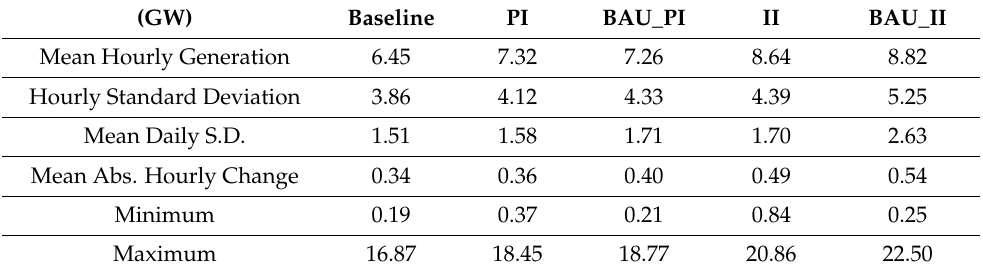
Table 4. Description of the generation from onshore wind, offshore wind, wave and tidal by scenario, showing the reduction in variability in all cases for the island capacity scenarios PI and II relative to their offshore wind counterparts BAU_PI and BAU_II.